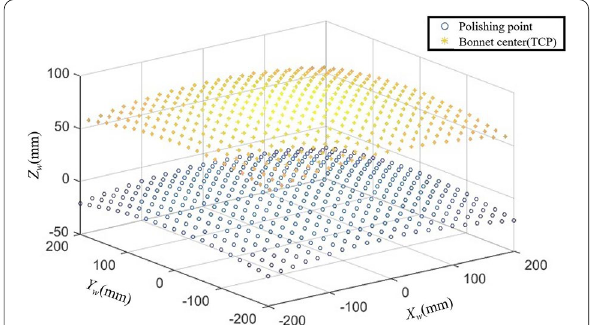
Figure 4 Position distribution of bonnet center (TCP)